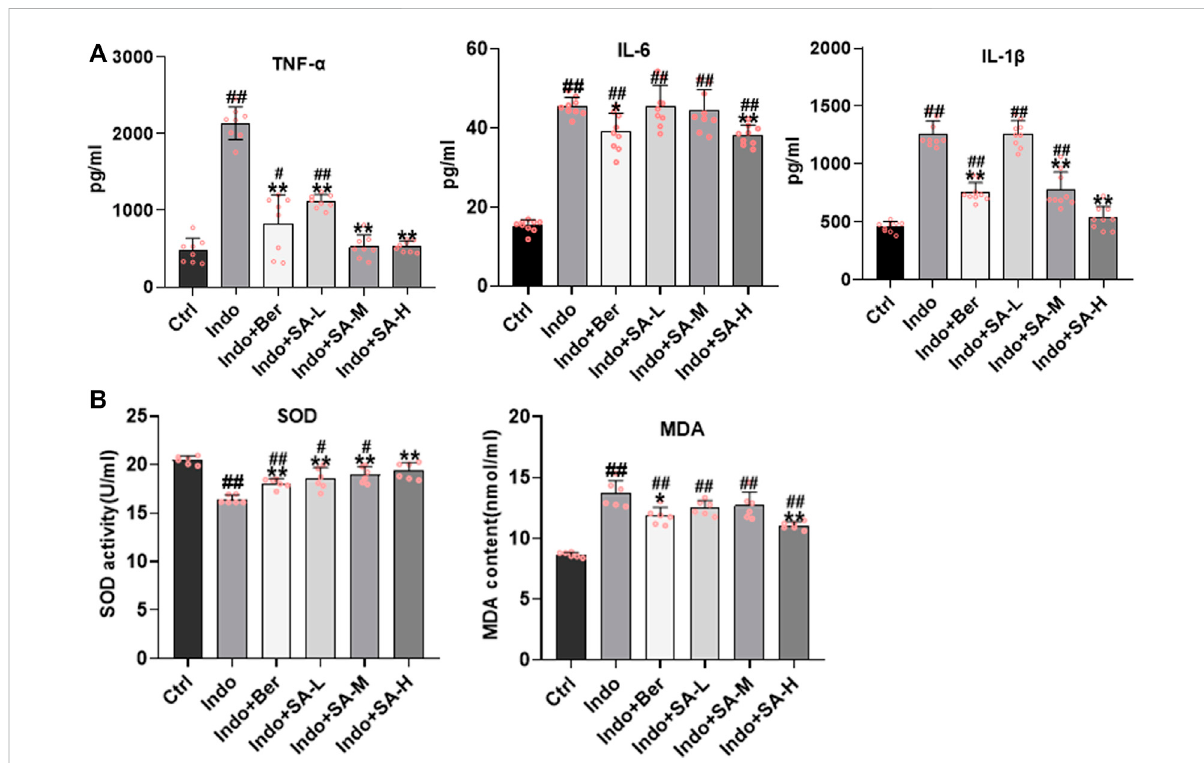
FIGURE 3 Inhibition of SA on indomethacin-induced intestinal in fl ammatory response and oxidative stress in rats. Male SD rats were treated with indomethacin (Indo, 7.5 mg kg − 1 ) alone or with sanguinarine (SA, 0.33 mg kg − 1 , 1.0 mg kg − 1 , 3.3 mg kg − 1 , SA-L, SA-M and SA-H, respectively) or with berberine (Ber, 60 mg kg − 1 ). The jejunum tissue of SD rats was collected and the supernatant was homogenized. After the protein was balanced, it was detected by ELISA, and the serum was detected by oxidative stress index. (A) In fl ammatory cytokines. TNF- α ( left ), IL-6 ( middle ), and IL-1 β ( right ) were measured by ELISA. (B) Oxidative stress. Super Oxide Dismutase (SOD) and Malondialdehyde (MDA) were estimated using a colorimetric assay kit and a chemiluminescent assay kit, respectively. Data are presented as the mean ± SD ( n = 6). # p < 0.05 and ## p < 0.01 vs. control (Ctrl). * p < 0.05 and ** p < 0.01 vs. indomethacin